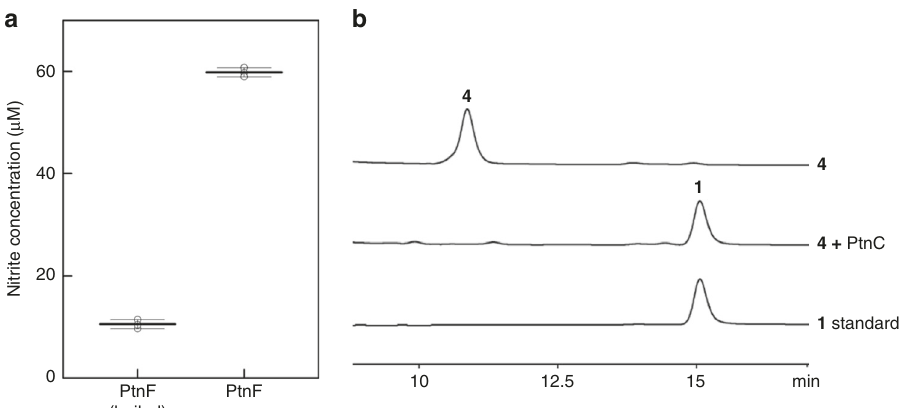
Fig. 3 In vitro biochemical assays of PtnF and PtnC. a Detection of nitrite production in biochemical assays of PtnF by Griess reagent. Three independent tests were taken. b Detection of 1 production in biochemical assays of PtnC by HPLC (detection wavelength =